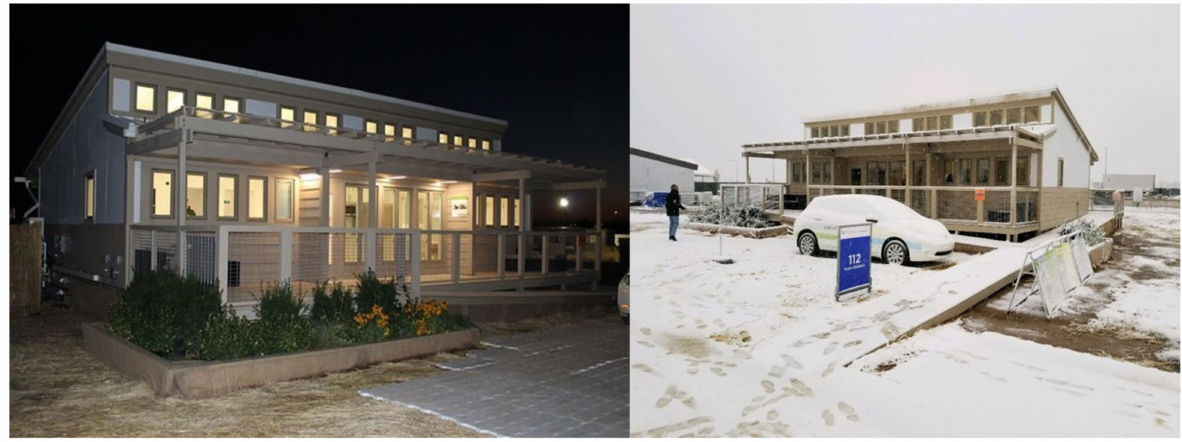
Figure 1. Photo of the exterior of the house as was assembled in Denver, CO. (( Left ): view at night, ( Right ): after the unexpected